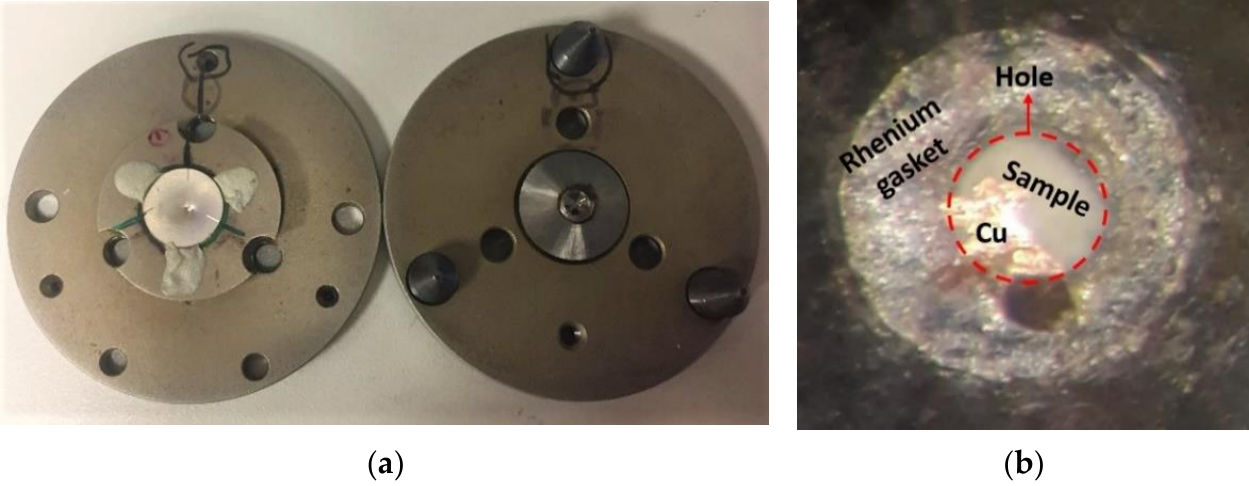
Figure 4. ( a ) Lower (on the left) and upper (on the right) plate of the 300 µ m DAC by Boehler-Almax. The upper diamond is observable, meanwhile the lower one is covered by the gasket, which is fixed onto its holder by using some play dough. ( b ) The pressure chamber filled with the sample powders. The internal standard (Cu) and the PTM are present.